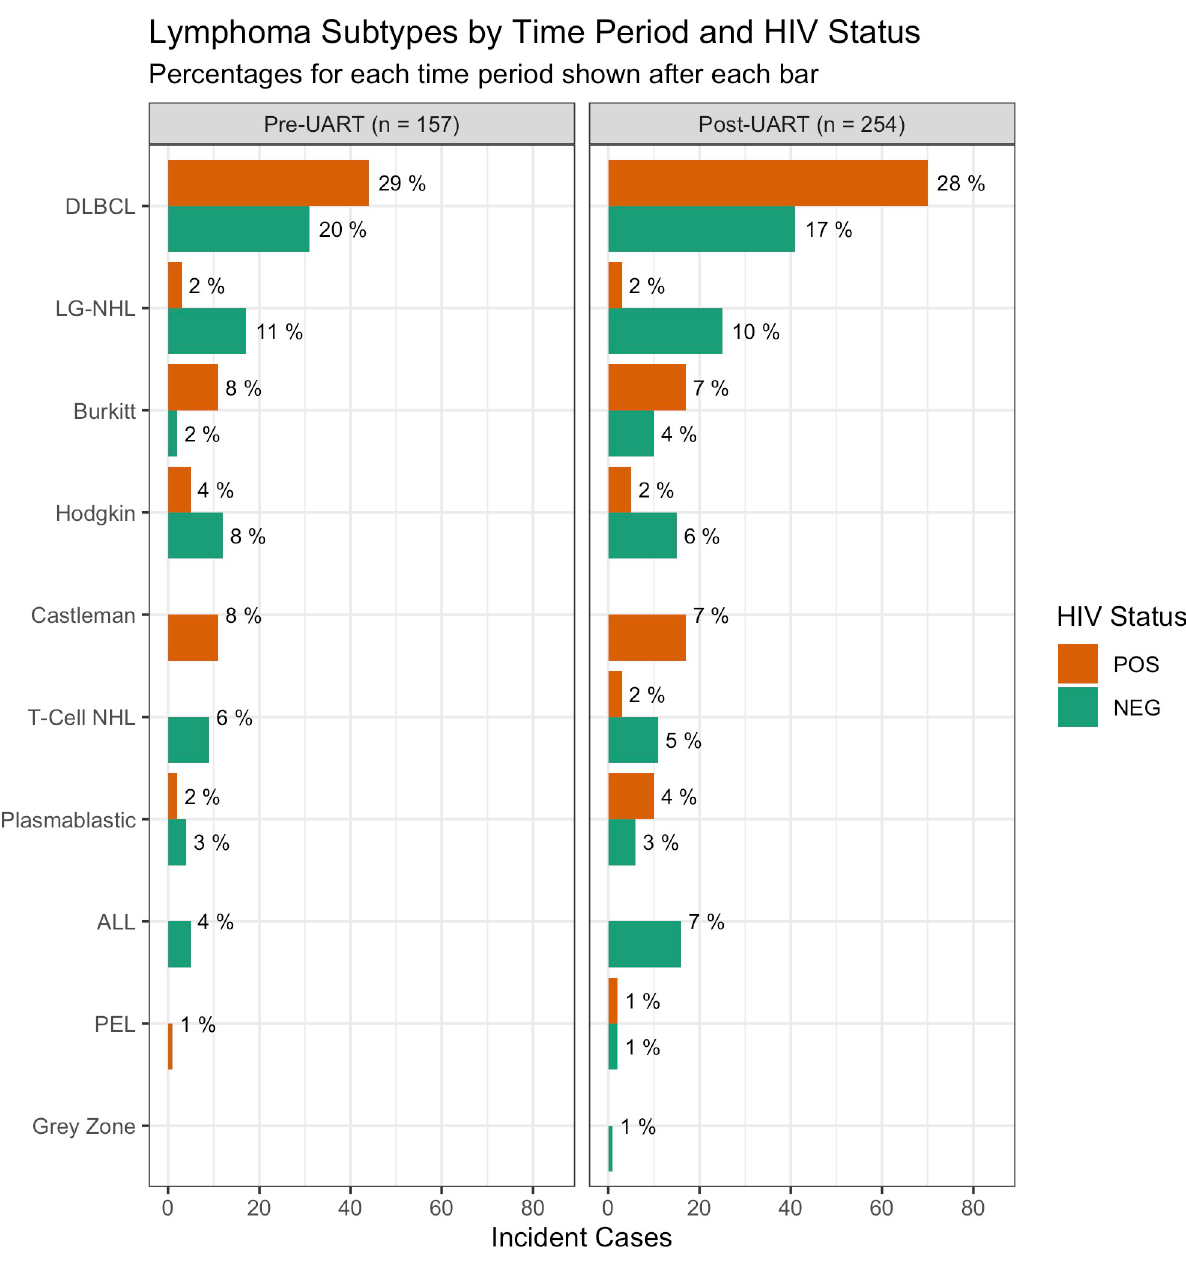
Fig 1. Distribution of lymphoma subtypes by HIV status in the pre-universal ART and post-universal ART period. Shown are absolute number of cases on the x-axis and percentage for the time period on the bar graph labels. � HIV status missing for one participant in post-UART. Abbreviations: pre-universal ART (pre-UART); post-universal ART (post-UART); Diffuse large B-cell lymphoma (DLBCL); low-grade non- Hodgkin’s lymphoma (LGNHL); T-cell non-Hodgkin’s lymphoma (T-Cell NHL); acute lymphoblastic leukemia/lymphoma (ALL); primary effusion lymphoma